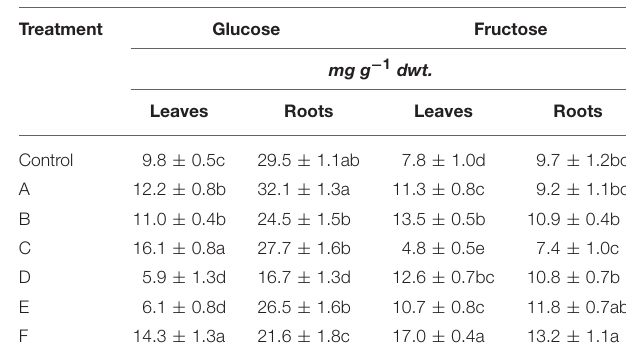
TABLE 5 | Glucose and fructose content in leaves and roots of control maize plants (untreated) and plants supplied for 48h with extracts obtained from the